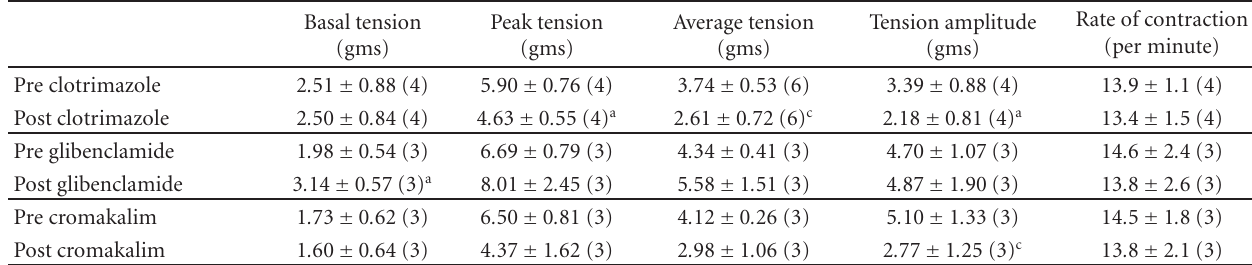
Table 2: The e ff ect of 100uM clotrimazole, 50 uM glibenclamide, and 7uM cromakalim on the tension and rate of smooth muscle contraction expressed as grams tension in the in vitro rabbit ileum incubated in Krebs-Ringer solution. Results are expressed as means ± standard error of the mean with the number of observations in parenthesis. Statistical significance ( a P < . 001; b P < . 02; c P < . 05) for comparison of parameters prior to and after drug